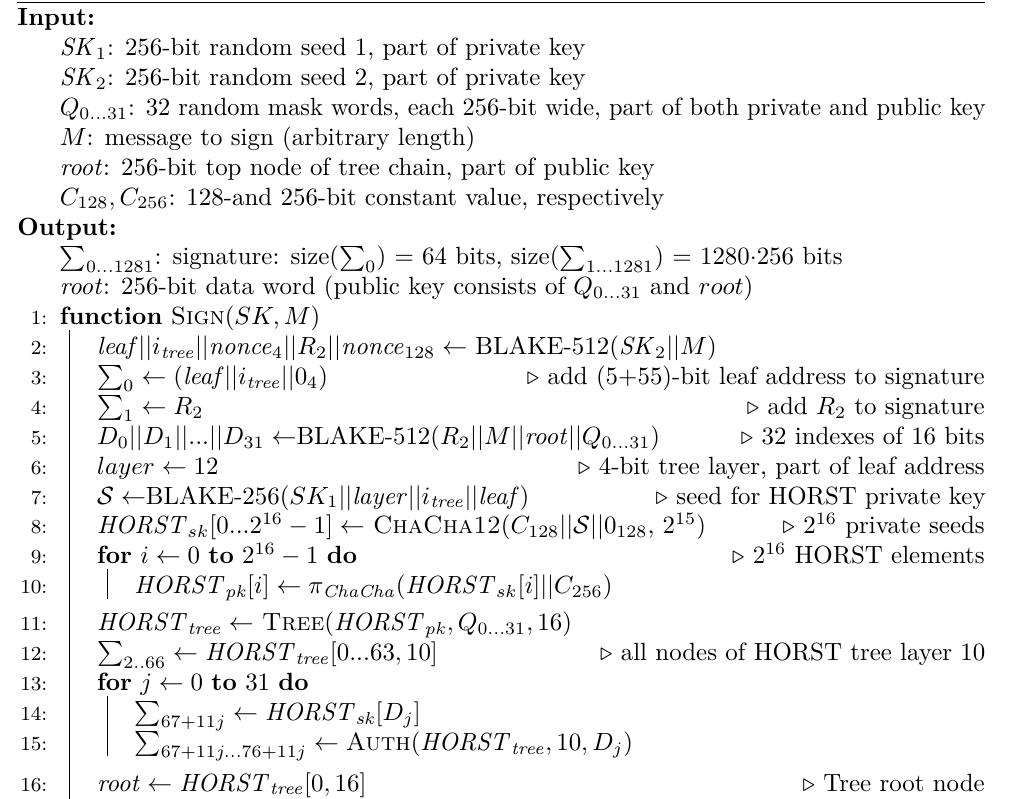
Algorithm 6 The SPHINCS-256 signing